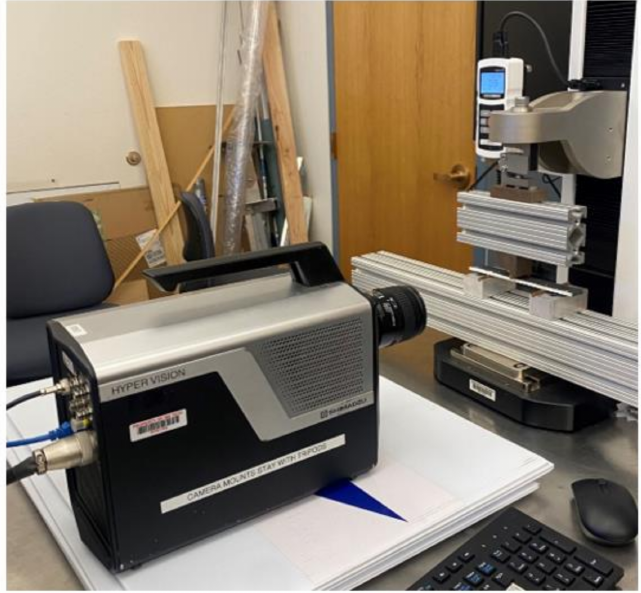
Figure 5. Experimental setup for the 3-point bending test of ML coated composite